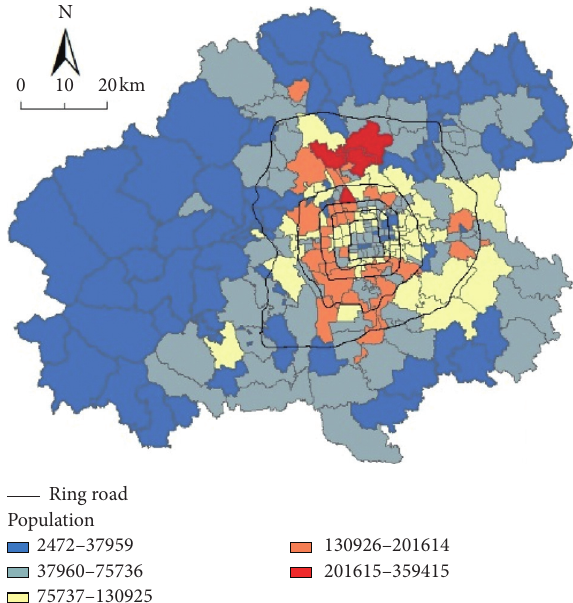
Figure 5: Population distribution map of the study